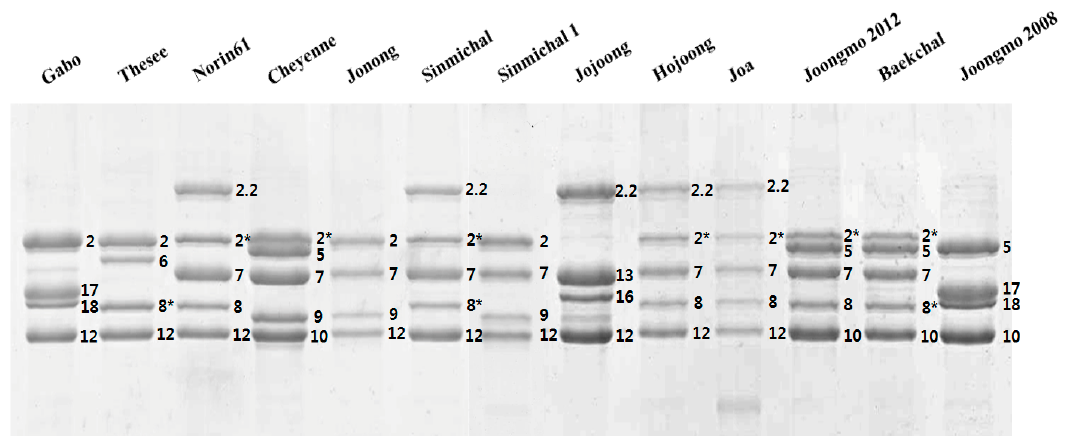
Figure 5. HMW-GS profiles of Korean wheat cultivars determined by SDS-PAGE. HMW-GS in Jonong, Sinmichal and Sinmichal 1 were incorrectly identified in previous SDS-PAGE analyses. HMW-GS from Jojoong, Hojoong, Joa, Joongmo 2012, Baekchal and Joongmo 2008 were determined in this study. Profiles of standard cultivars Gabo, Thesee, Norin61 and Cheyenne are shown for